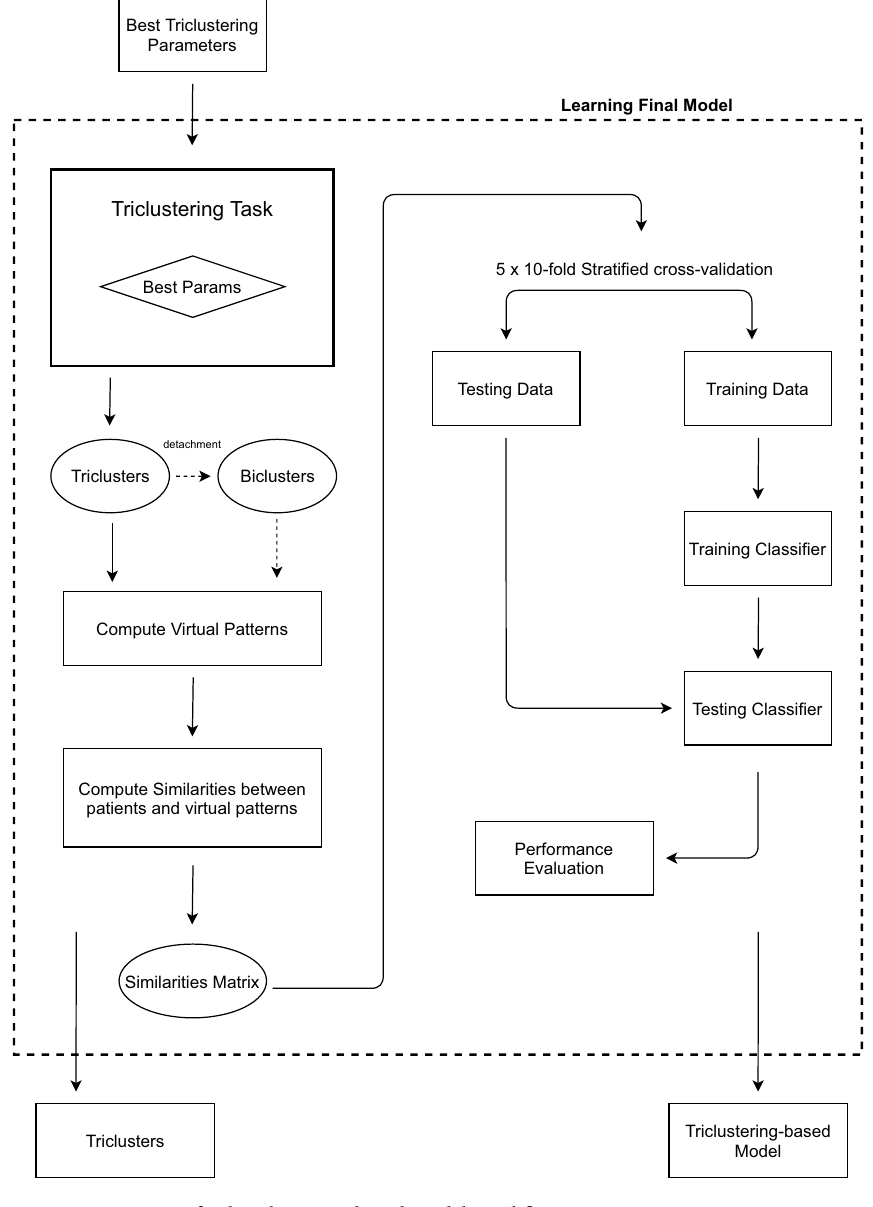
Figure 3. Learning final triclustering-based model: